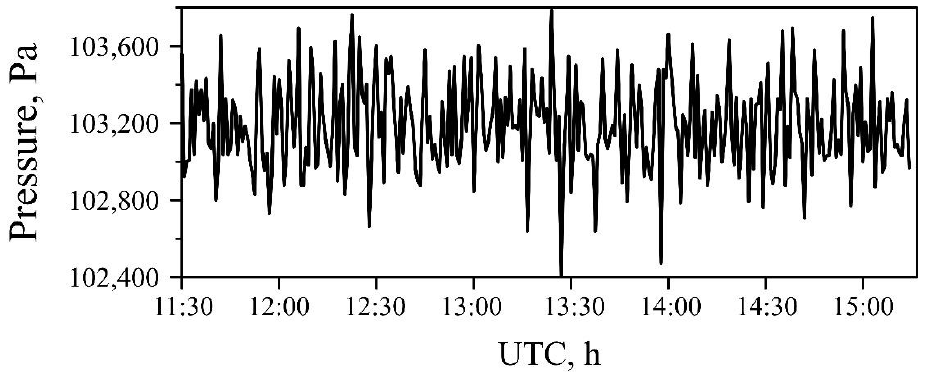
Figure 4. Pressure values near the Earth’s surface were obtained using experimental data on the intensity of the lidar signal.